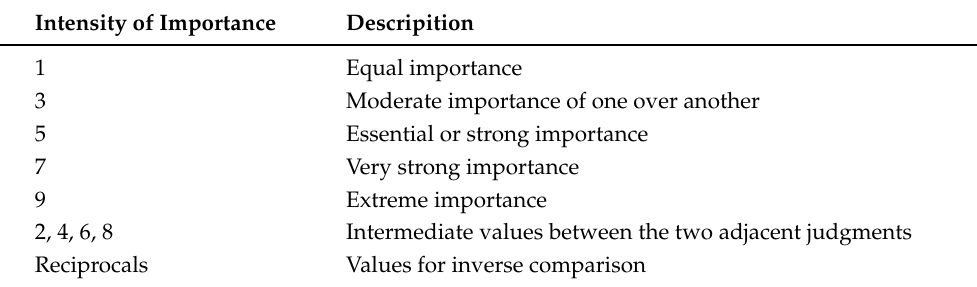
Table 1. Pairwise comparison scale for